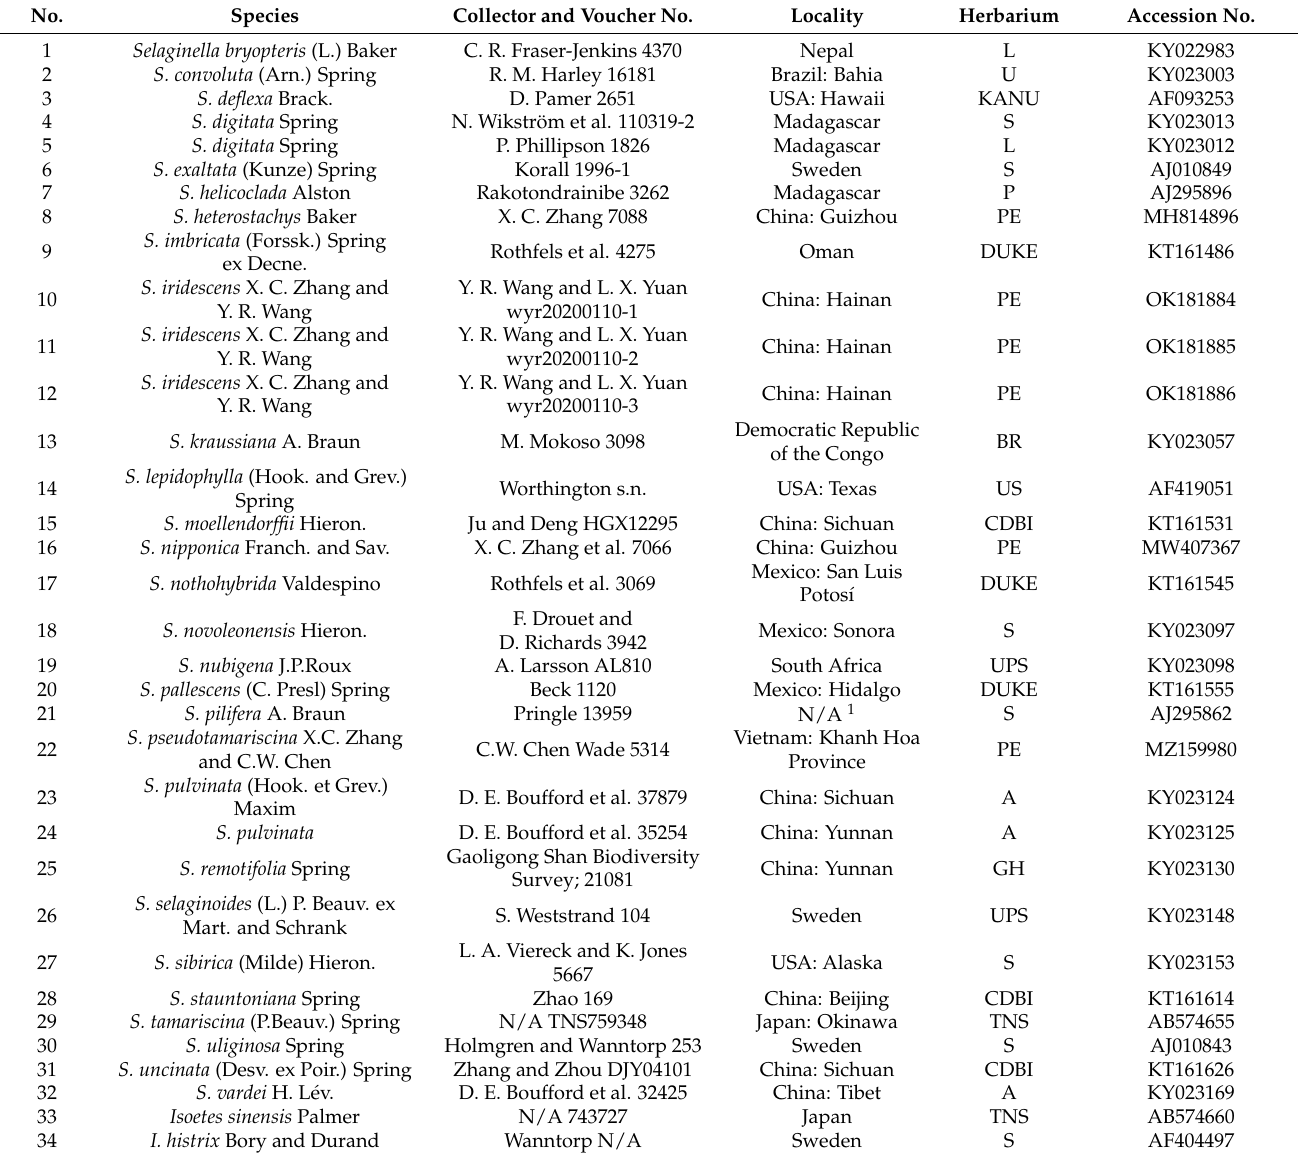
Table 1. Species names and GenBank accession numbers of rbcL sequences used in this